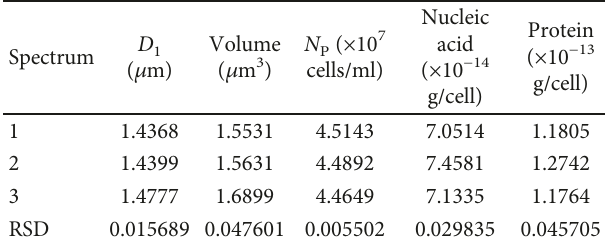
Figure 7: Three measured multiwavelength transmission spectra (230 – 820nm) of puri fi ed E. coli . Table 3: The calculated values from the three multiwavelength transmission